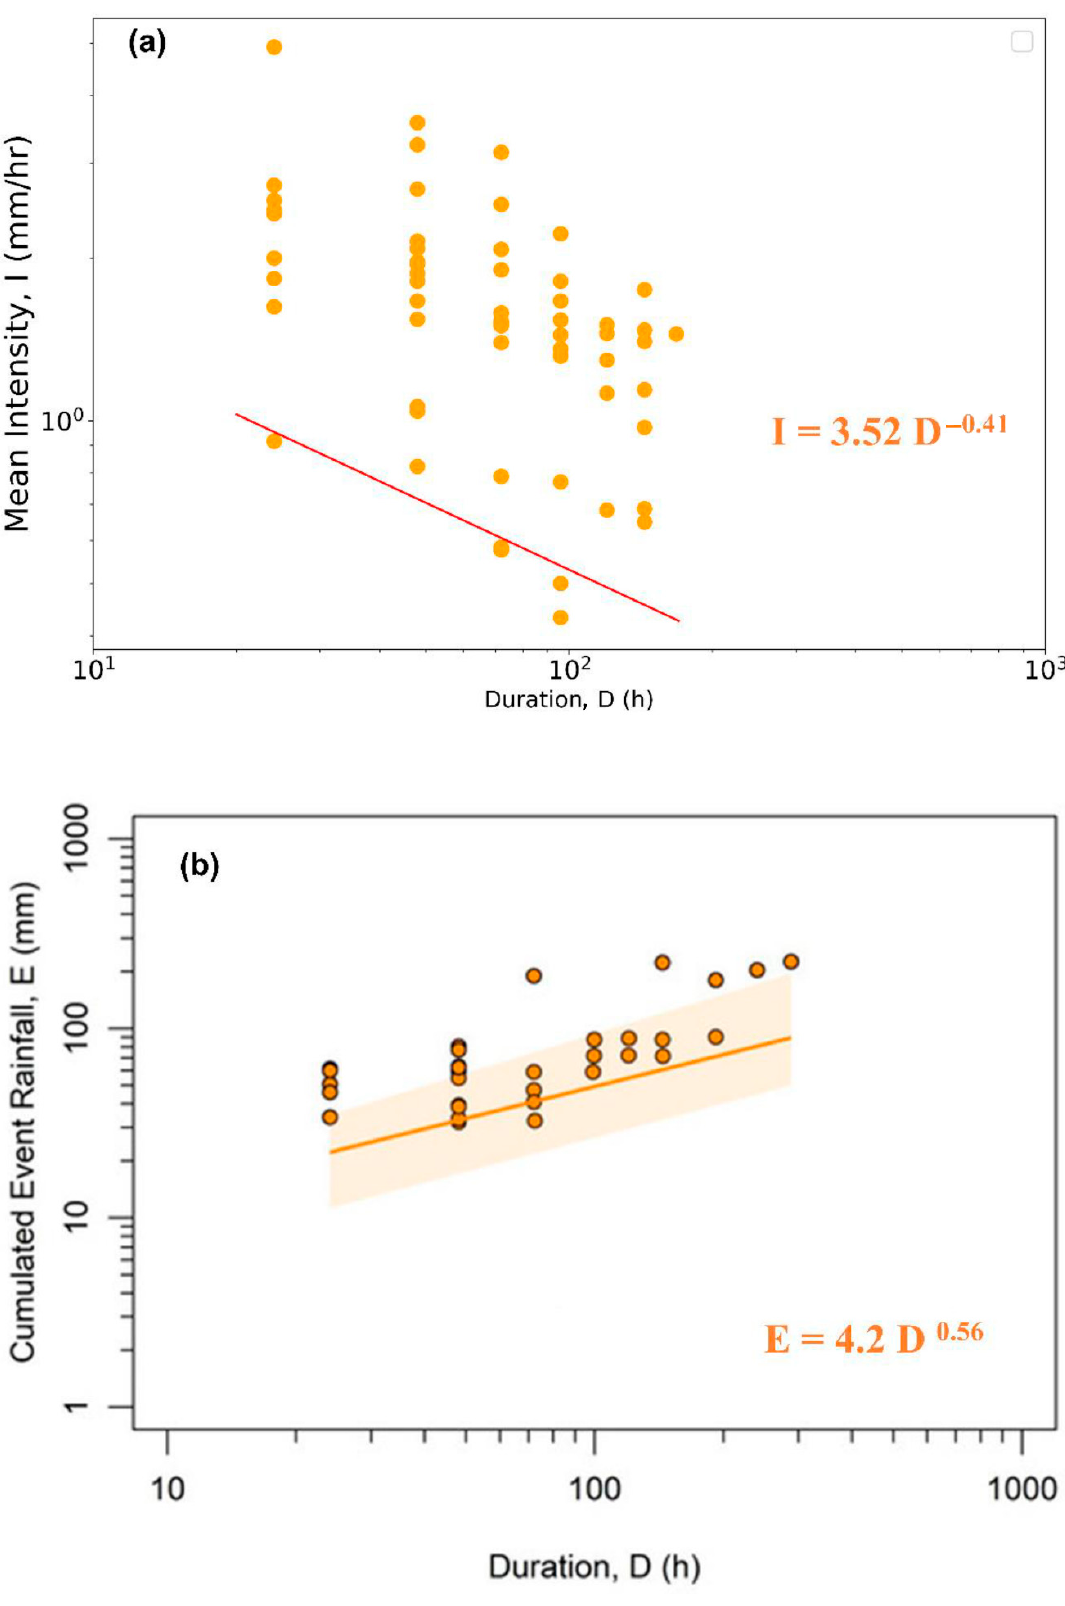
Figure 3. Empirical thresholds derived for Kalimpong along with the rainfall events considered for derivation of thresholds ( a ) ID threshold [58] and ( b ) ED threshold [22]. derivation of thresholds ( a ) ID threshold [58] and ( b ) ED threshold